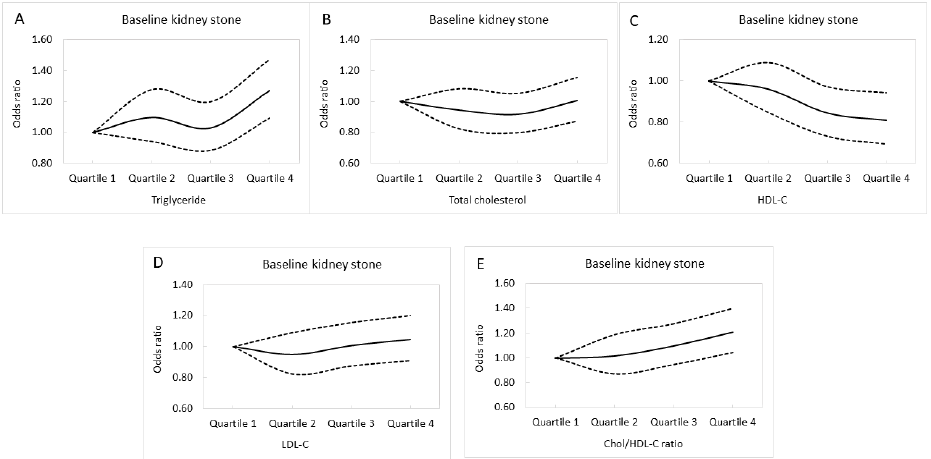
Figure 2. The adjusted curves of baseline kidney stone disease among the quartiles of triglyceride ( A ), total cholesterol ( B ), HDL-C ( C ), LDL-C ( D ), and Chol/HDL-C ( E ). HDL-C, high-density lipoprotein cholesterol; LDL-C, low-density lipoprotein cholesterol; Chol/HDL-C, the ratio of total cholesterol to HDL-C. Dashed lines mean odds ratio. Solid lines mean 95% confidence interval. After exclusion the participants with a history of KSD (n = 1813), the mean age of study population in the follow-up study (8471 males and 16,718 females) was 51.0 ± 10.4 years. The participants were stratified into two groups according to incident KSD ( − ) ( n = 24,549; 97.5%) or KSD (+) ( n = 640; 2.5%). 3.3. Comparison of Clinical Characteristics among Participants According to Incident KSD A comparison of the clinical characteristics among the two groups is shown in Table 3. Compared to the participants without incident KSD, those with incident KSD were older and male predominant and had higher smoking and alcohol history, higher prevalence of hypertension, higher fasting glucose, higher albumin, higher triglyceride, lower HDL-C, higher LDL-C, higher Chol/HDL-C ratio, and lower eGFR. However, total cholesterol was not significantly diffident between the two groups. Table 3. Comparison of clinical characteristics among participants according to incident kidney stone disease in study participants without baseline kidney stone disease ( n = 25,189). Characteristics